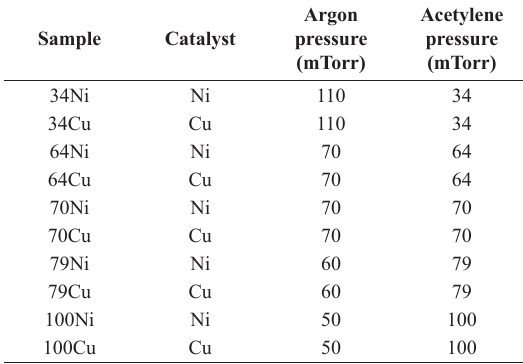
Table 1. Argon and C H partial pressures in the synthesis of each 2 2 sample. Thickness of Ni and Cu catalytic films: 3 nm. Deposition time: 20 minutes. Maximum temperature during depositions: 120